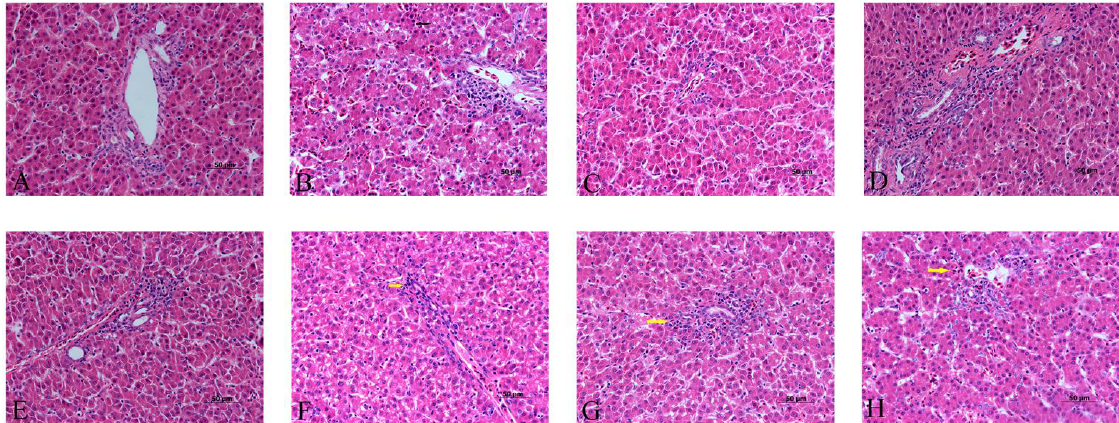
Figure 3. The effect of α -lipoic acid and chlorogenic acid on histopathology of cadmium-exposed chicken liver (50 µ m). ( A ): Control group, ( B ): Cd group, ( C ): α -LA group, ( D ): CGA group, ( E ): α -LA + CGA group, ( F ): Cd + α -LA group, ( G ): Cd + CGA group and ( H ): Cd + α -LA + CGA group.